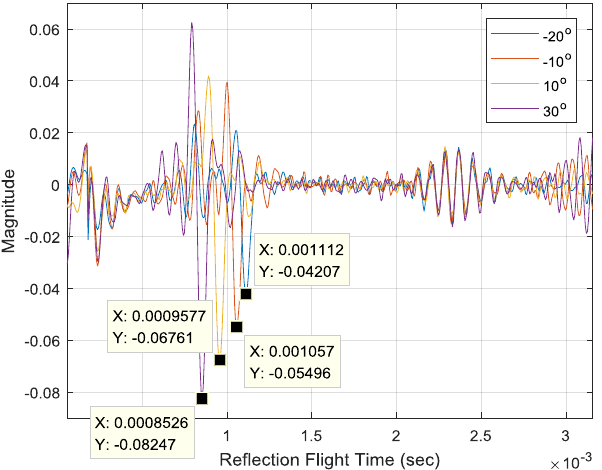
Figure 10. Simulated homomorphic deconvolution (HD) outputs for structure-related impulse response (SRIR).